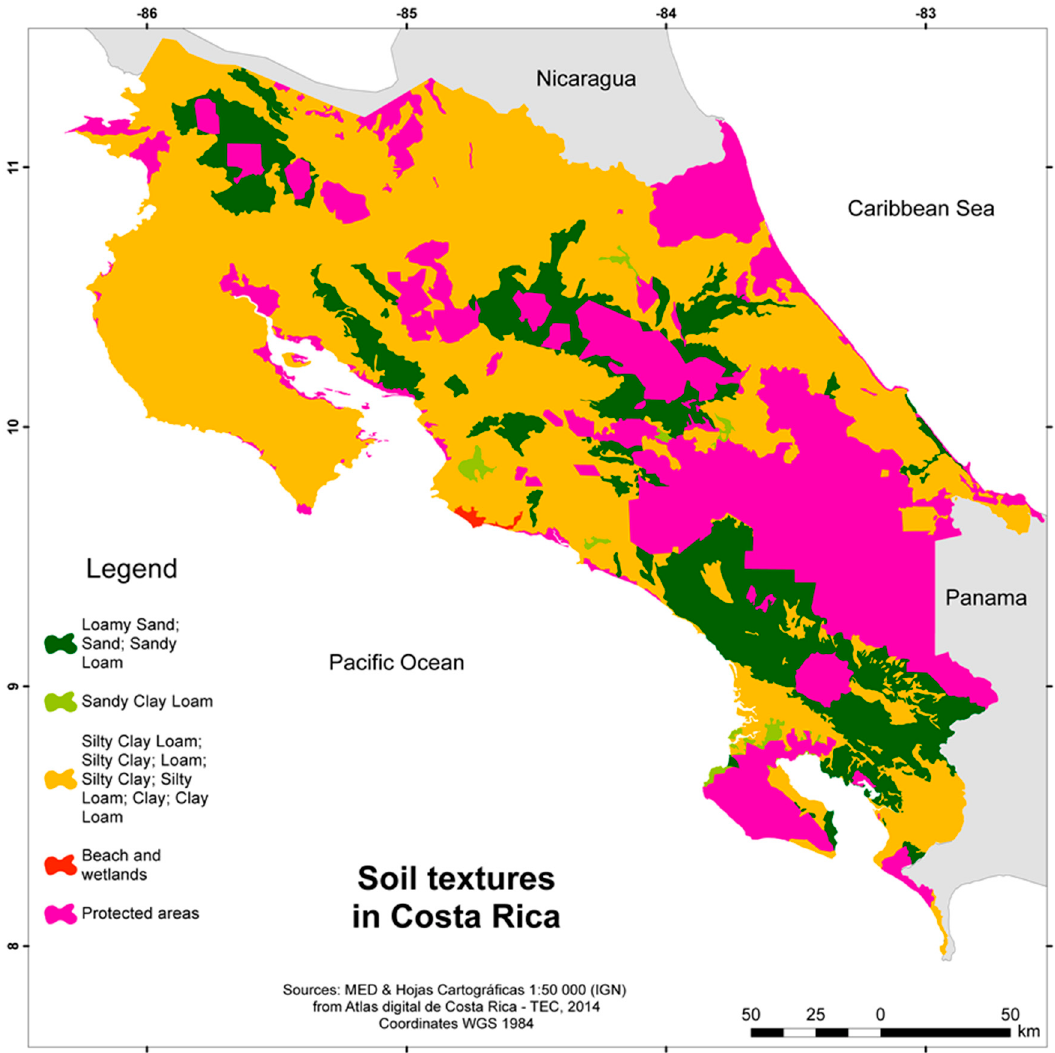
Figure 4. Soil texture based on the soil data collected by the Ministry of Agriculture of Costa Rica (MAG, in Spanish) digitalized by TEC [44].